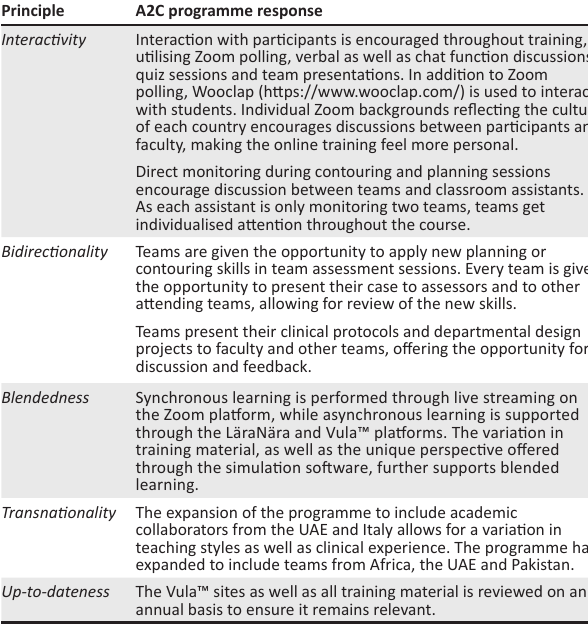
TABLE 3: Alignment with the principles of modern medical